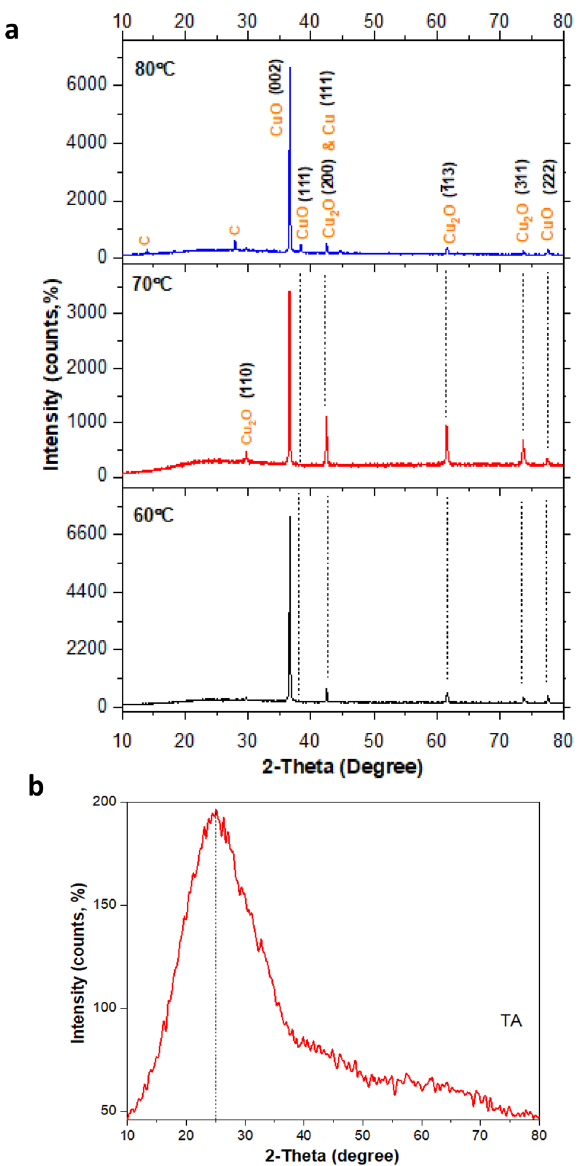
Figure 8. The XRD pattern of Cu-based oxide nanostructures prepared at ( a ) 60, 70 and 80 °C with the ( b ) TA pattern for